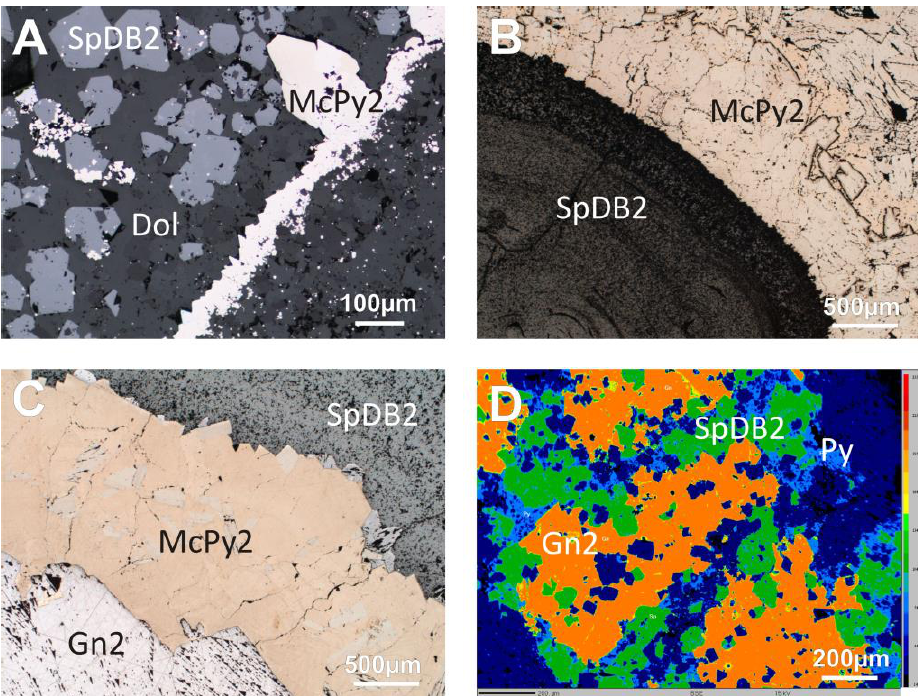
Figure 14. Photomicrographs of sphalerite-galena-marcasite ore from the Zn-Pb (MVT) deposits in Poland: ( A ) Euhedral sphalerite (Sp) and marcasite (McPy2) scattered in ore-bearing dolomite (Dol), reflected light, Z9 borehole; ( B ) massive marcasite (McPy2) encrusted on colloform sphalerite (SpDB2), reflected light, the Pomorzany mine; ( C ) colloform texture of massive galena (Gn2), euhedral marcasite (McPy2), and porous sphalerite (SpDB2), sample from the Klucze I deposit, reflected light; and ( D ) automorphic crystals of galena (Gn2) overgrown by sphalerite (SpDB2) and pyrite (Py), backscattered-electron imaging BSEI, false colors (red, high values of BSEI brightness and dark blue, low values of BSEI brightness), TN-314 borehole.